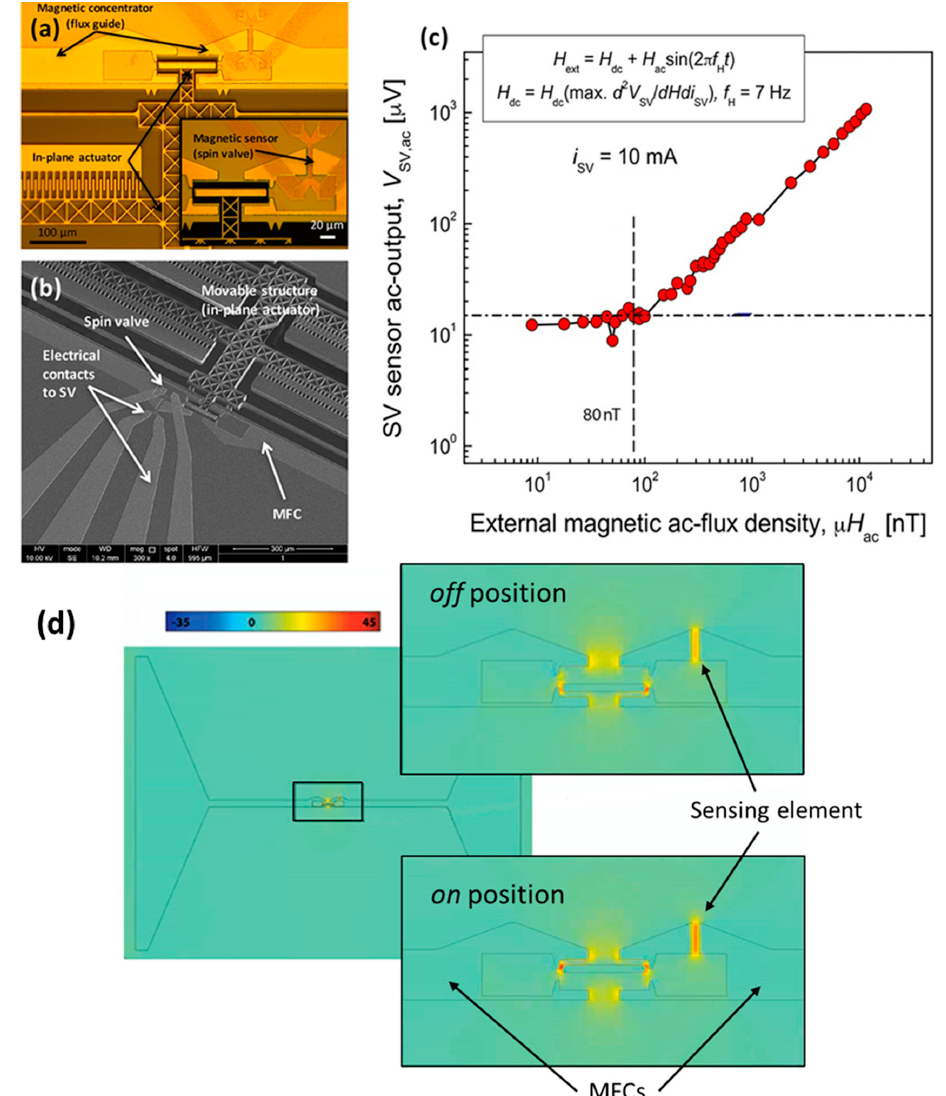
Figure 11. ( a ) Optical and ( b ) SEM image of modulator combining in-plane electrostatic microactuators with interdigitated fingers comb drive, SV sensors and MFCs; ( c ) Modulated sensor output as a function of magnetic field amplitude at low frequency (7 Hz); ( d ) Finite element simulation which illustrates the concentrated magnetic flux in the sensing element for the two positions: off-minimum concentration; on-maximum concentration.